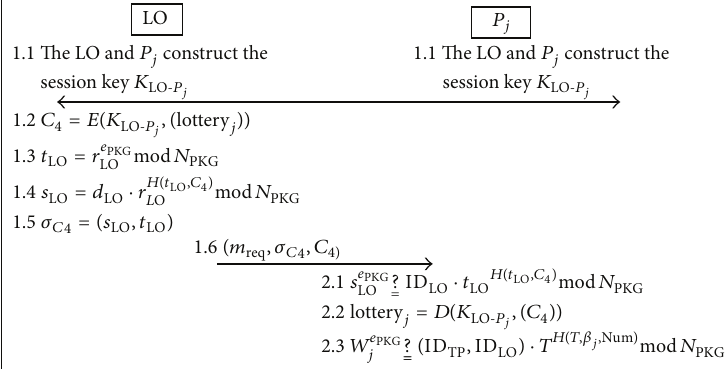
Figure 4: Overview of the lottery issue phase.